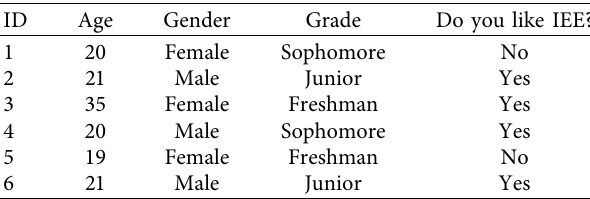
Table 3: QS initial sample dataset.